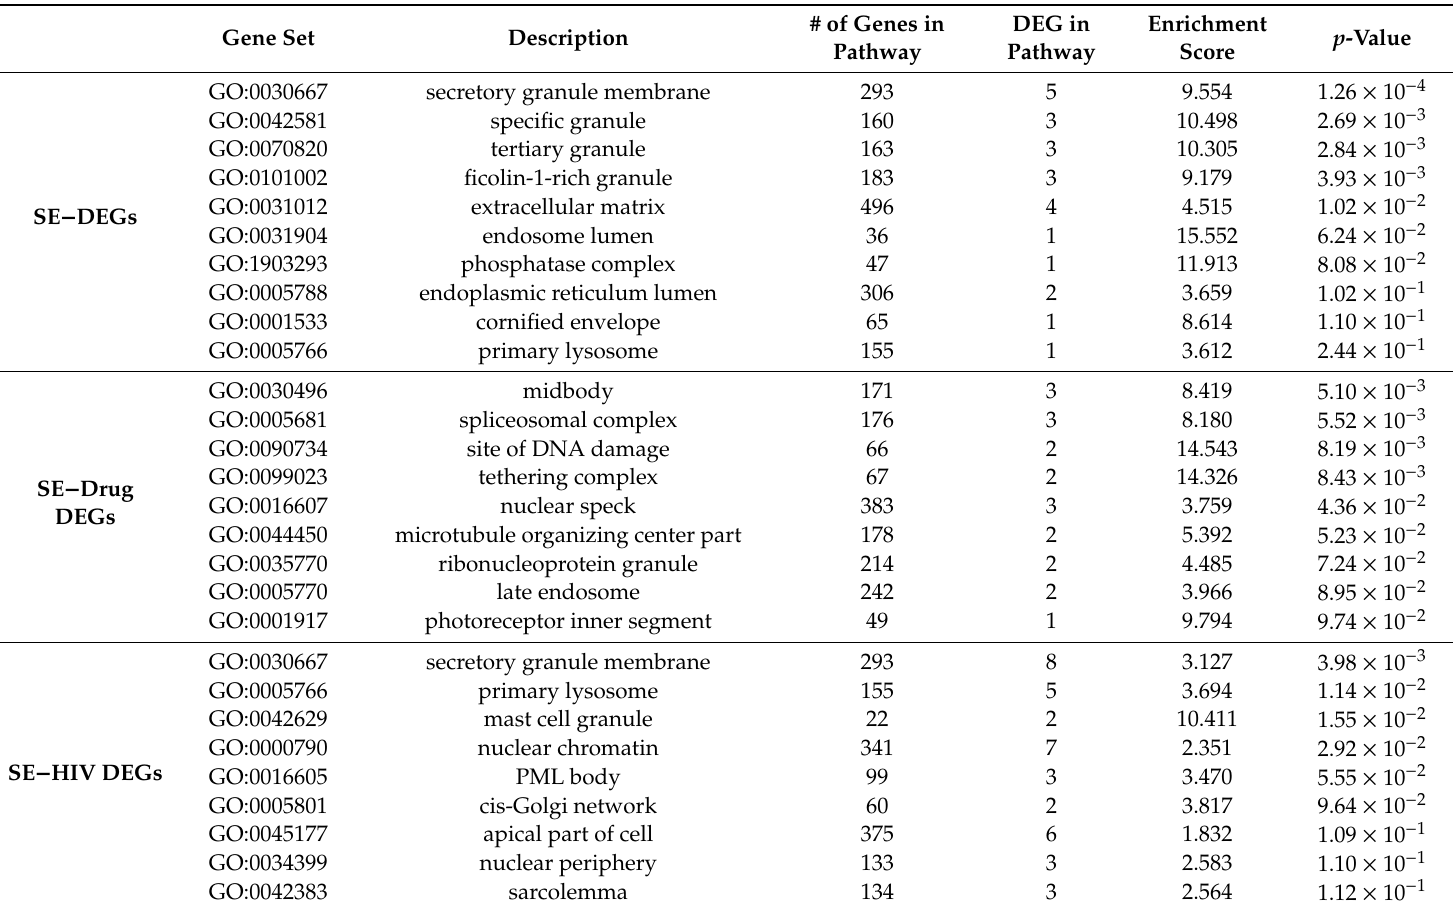
Table 6. Top 10 cellular component GO terms from Webgestalt analysis 1